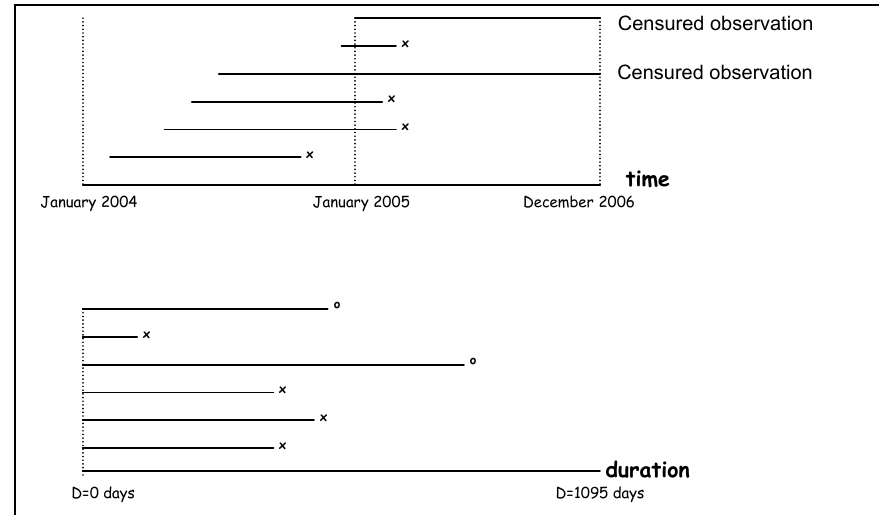
Figure 1 – Diagram of the construction of data for the purposes of estimating survival